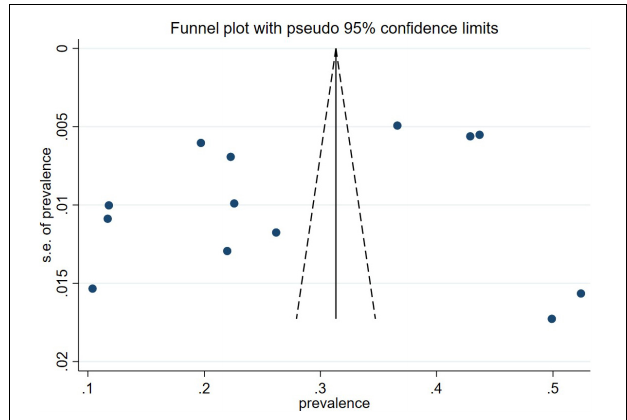
FIGURE 3 | Funnel plot of depressive symptoms.